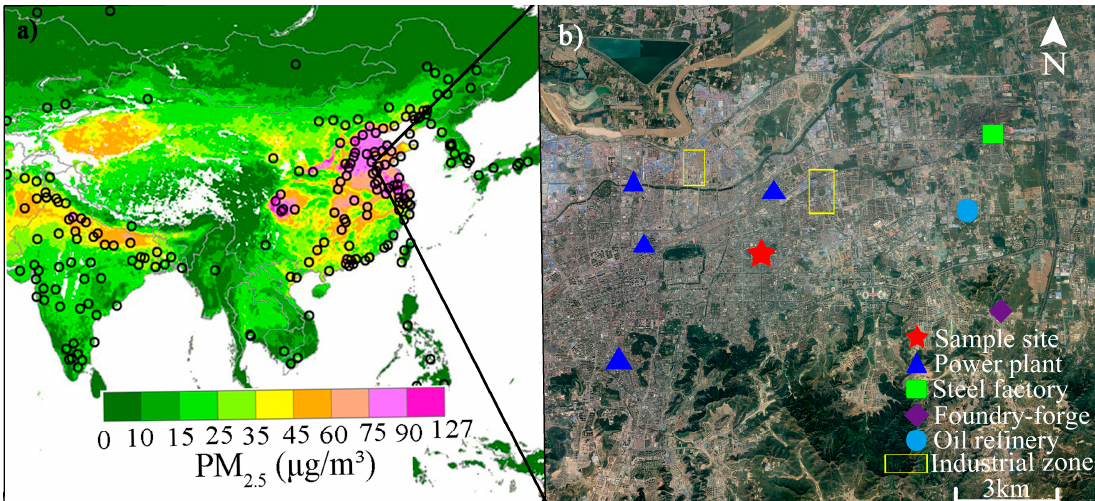
Figure 1. ( a ) Daily concentration of PM 2.5 ( μ g/m 3 ) in China [30], and ( b ) the locations of the sampling site (red star) and surrounding major anthropogenic emission sources (other shapes). A total of 176 PM 2.5 samples were collected on 90-mm pre-heated quartz fiber filters (MUNKTELL, Sweden) using a medium volume particulate sampler (100 L/min). The sampling